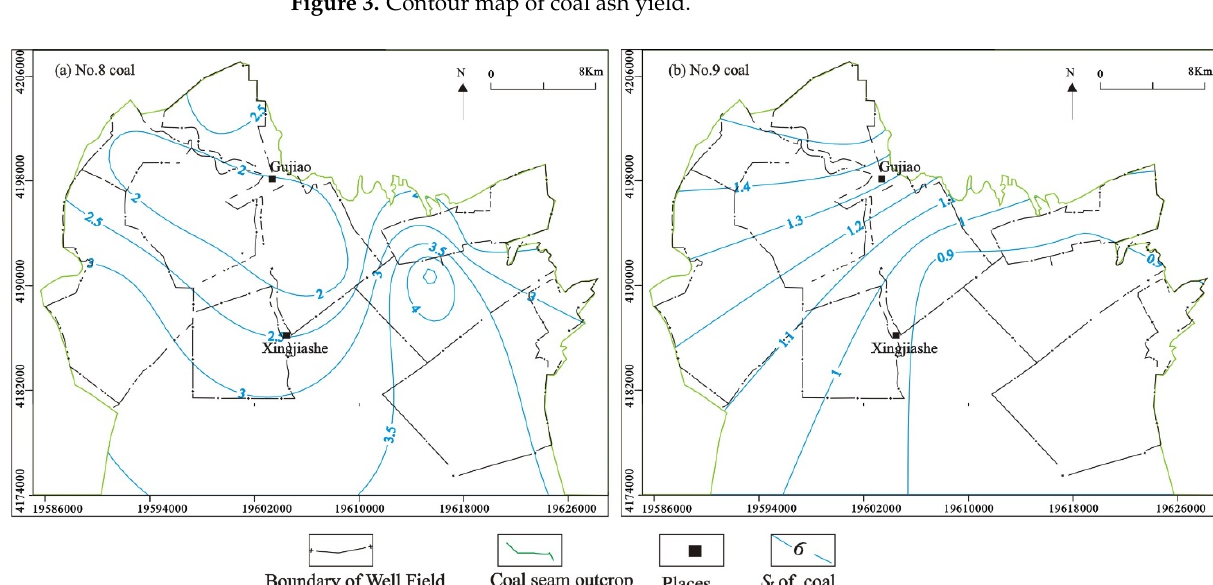
Figure 4. Contour map of total sulfur in coal seam.